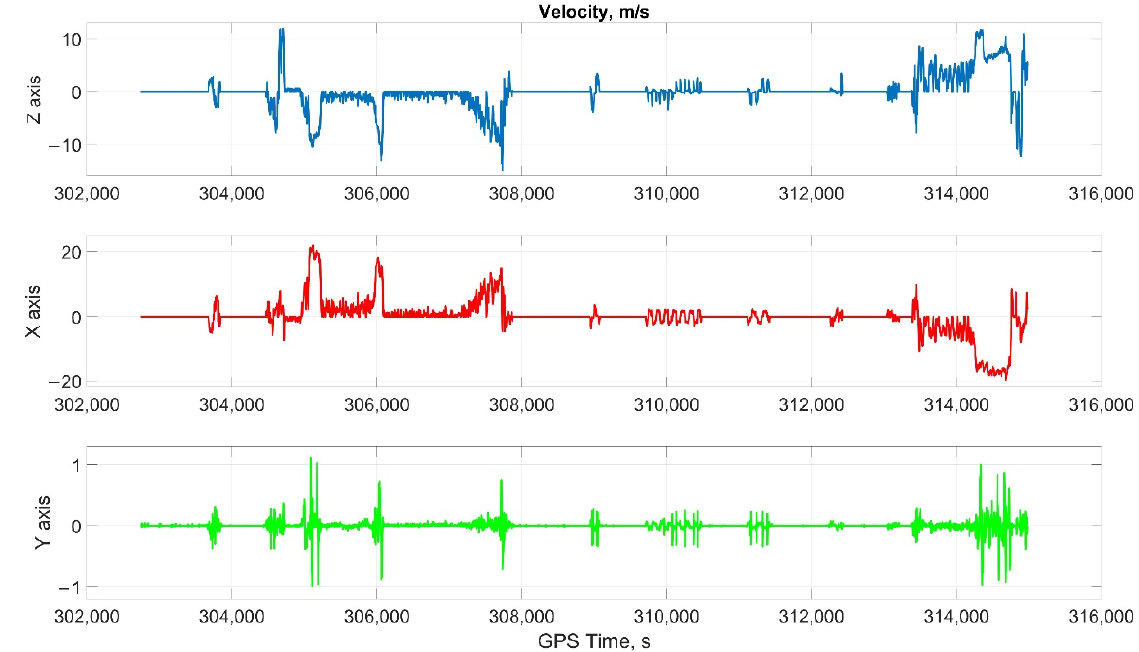
Figure 7. The north, east, and up velocity projections in car test.